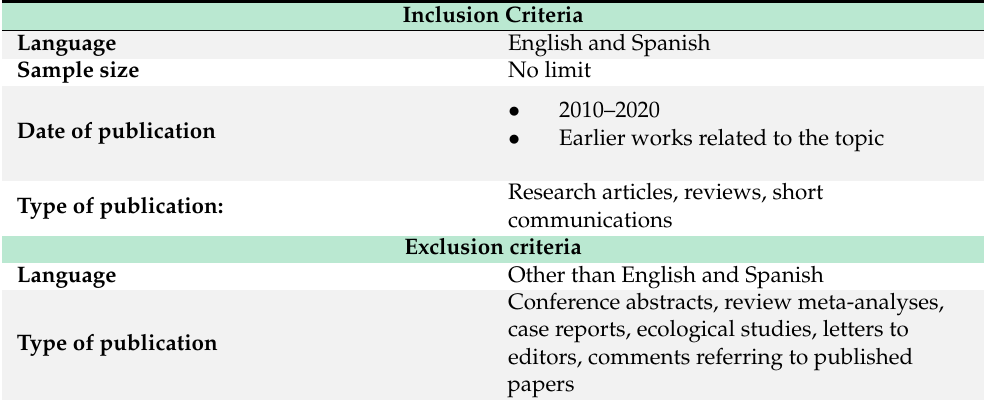
Table 1. Representation of the inclusion and exclusion criteria used for the study of the literature. Inclusion